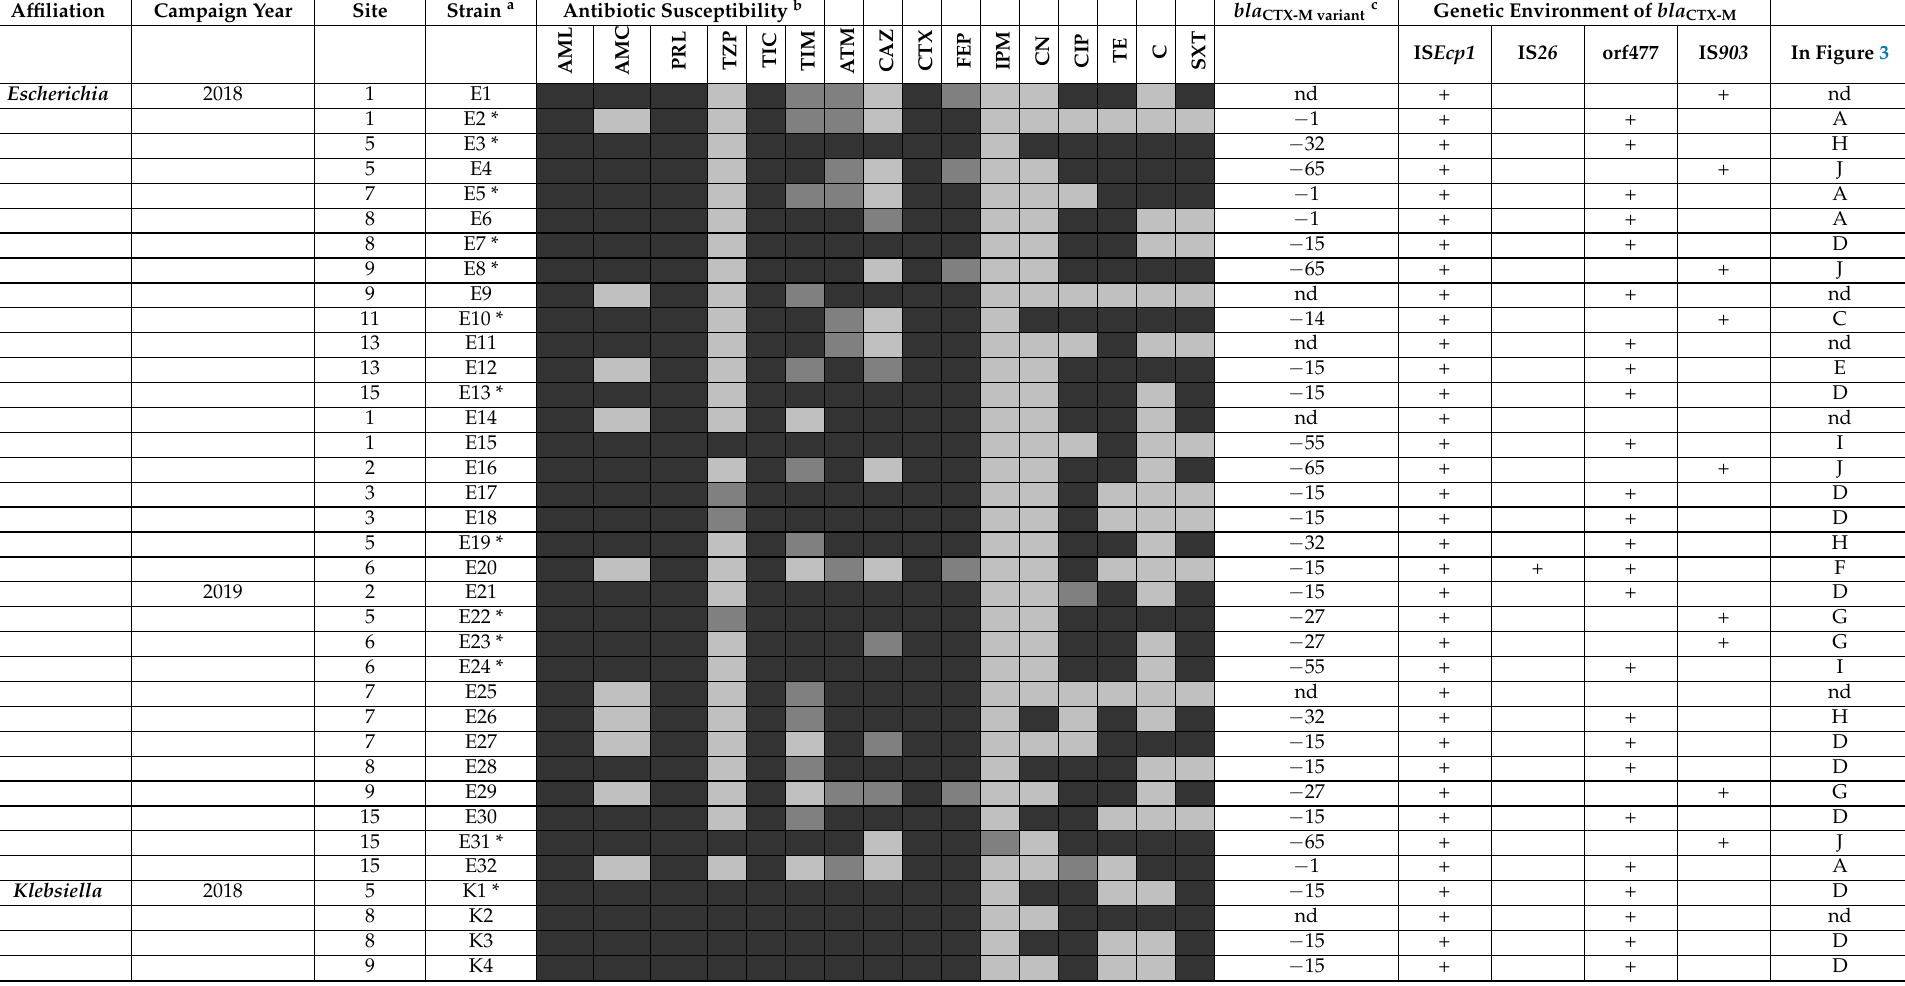
Table 1. Description of bla CTX-M carriers isolated in the Lis River concerning isolation year and location, identification, antibiotic susceptibility profiles (black— resistant, grey—intermediate resistance, white—susceptible), and bla CTX-M variant detected and genomic